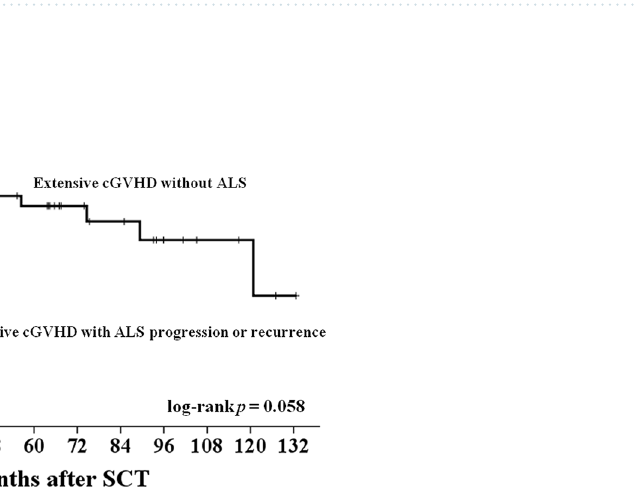
Figure 2. Kaplan–Meier curves of overall survival of cGVHD patients with or without post-transplant thoracic ALS.